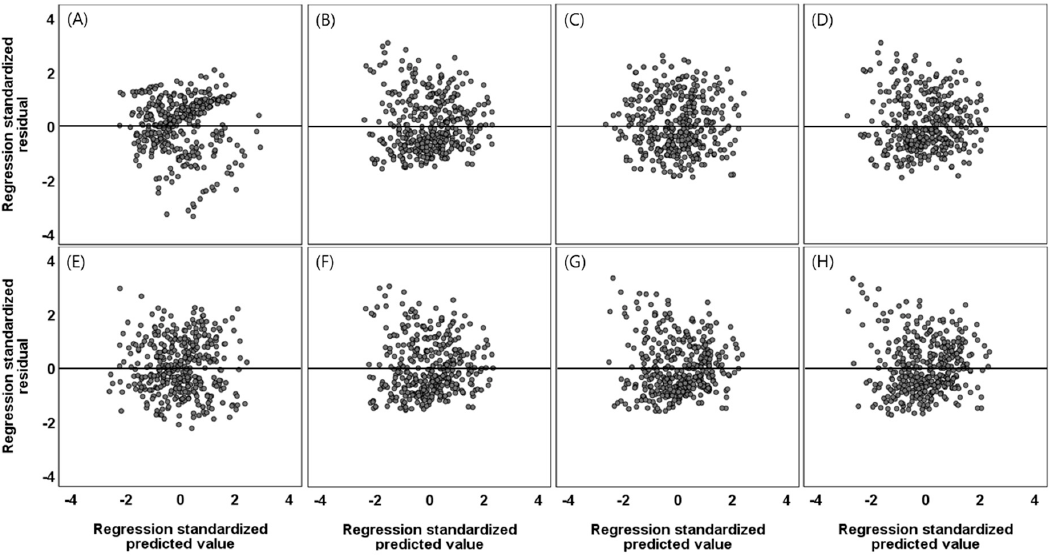
Figure 7. Scatter plot of the standardized predicted values and standardized residuals for each regression Model ( A – H ): Model A = axle torque as a linear function of engine torque and engine speed; Model B = axle torque as a linear function of tillage depth; Model C = axle torque as a linear function of slip ratio and travel speed; Model D = axle torque as a linear function of engine torque, engine speed and tillage depth; Model E = axle torque as a linear function of engine torque, engine speed and travel speed; Model F = axle torque as a linear function of tillage depth and travel speed; Model G = axle torque as a linear function of engine speed, tillage depth and travel speed; and Model H = axle torque as a linear function of engine torque, tillage depth and travel speed.